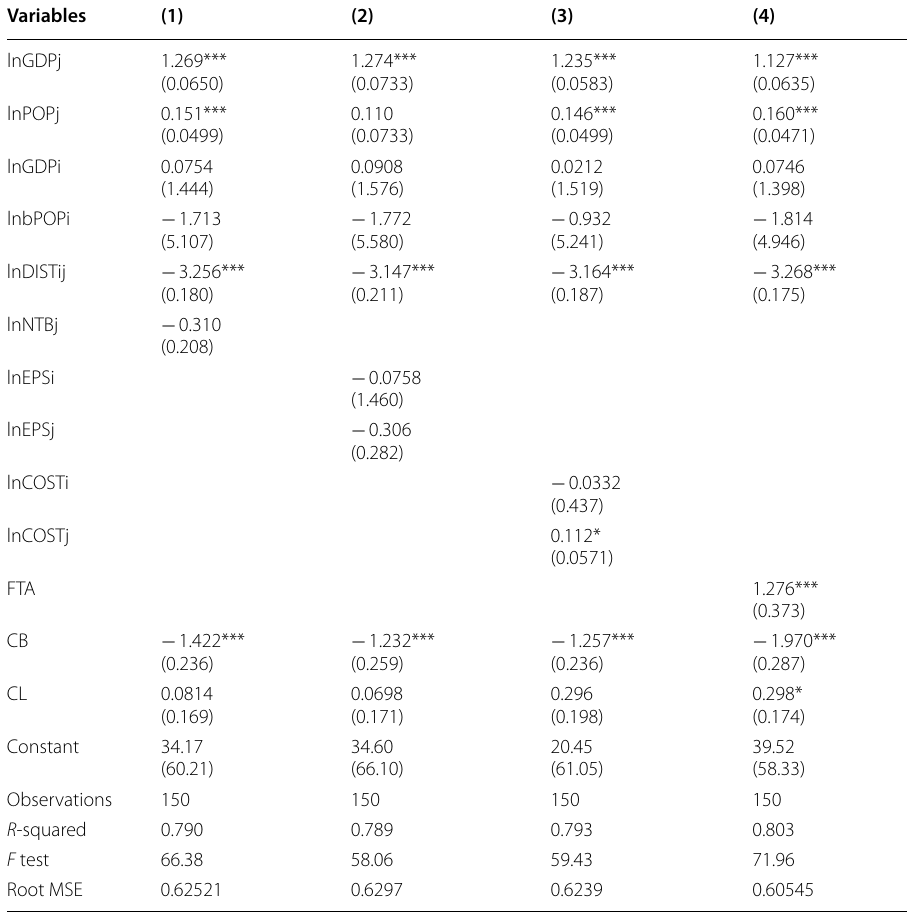
Table 4 The effect of trade policy specificities on imports